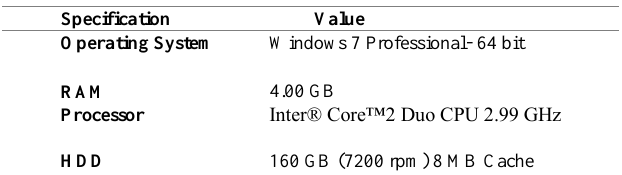
Table 11. Test system configuration.